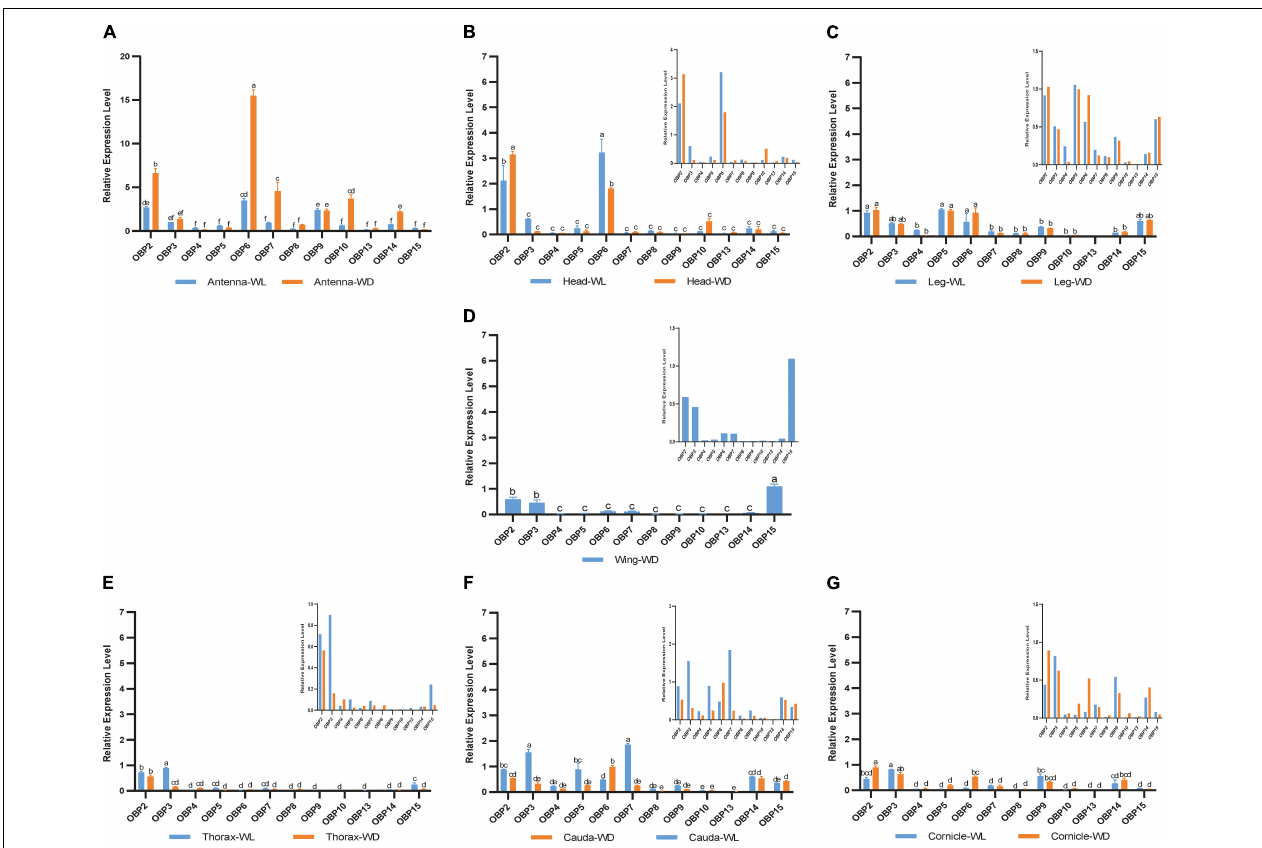
FIGURE 4 | RT-qPCR detection of 12 OBP expression patterns at the mRNA level in each tissue. WL, wingless; WD, winged; bars represent the standard deviation of the mean for three independent experiments. (A–G) are the results of 12 OBP expression patterns in antennae, heads, legs, wings, thoraxes, caudae, and cornicles, respectively. The letters above bars (a–f) are the result of a multicomparison, which indicated significant differences from other samples with different letters ( p <